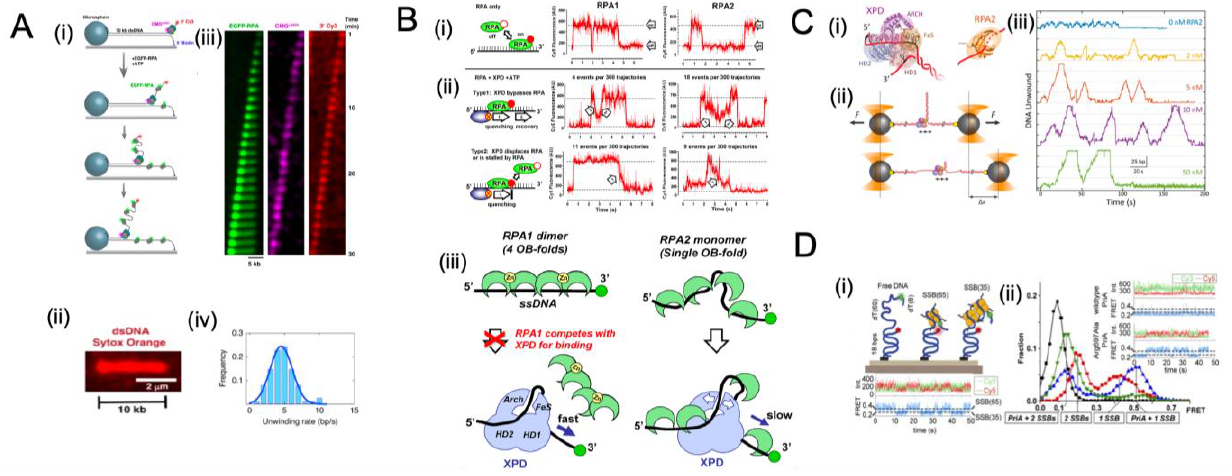
Figure 5. Overview of single-molecule studies on SSB interacting with helicase. (A) Direct visualization of the RPA-facilitated unwinding of processive forks by CMG helicases. The unwinding was performed on a 10kb λ -DNA fragment with a short fork construct (i), which was stained with Cy3 and immobilized on a cover glass. The LD655-labeled CMG was bound to the dT40 ssDNA in the presence of ATPγS. (ii) A representative snapshot of the flow- stretched λ -DNA stained with a fluo- rescent dsDNA intercalator, SYTOX Orange. EGFP-RPA and ATP were then introduced to initiate the unwinding, which was observed to occur as the EGFP-RPA bound both strands of the unwound DNA (iii). A histogram of the CMG-catalyzed DNA-unwinding rates is also shown (iv). Images adapted from Figure 1 of [38] under a Creative Commons Attribution 4.0 International license. (B) Two different mechanisms of xeroderma pigmentosum group D (XPD) helicase translocating along